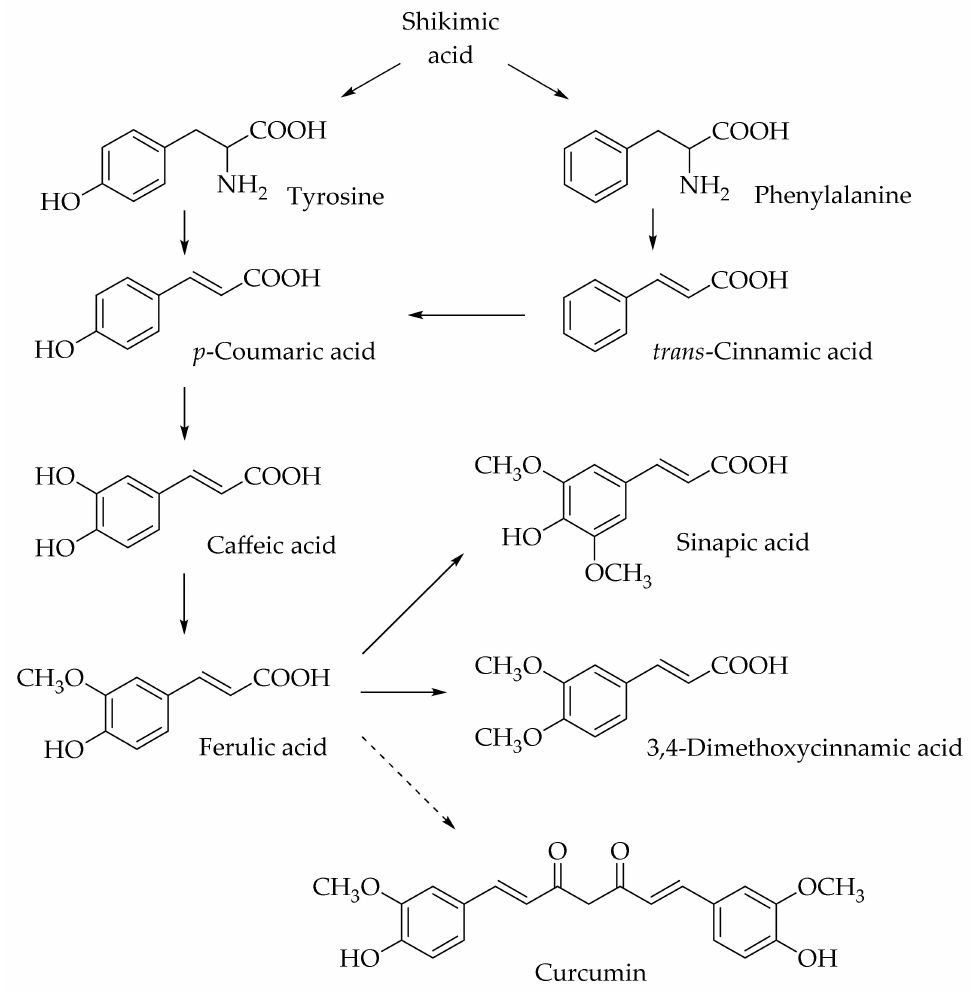
Figure 1. Biosynthesis and structures of naturally occurring hydroxycinnamic acids and